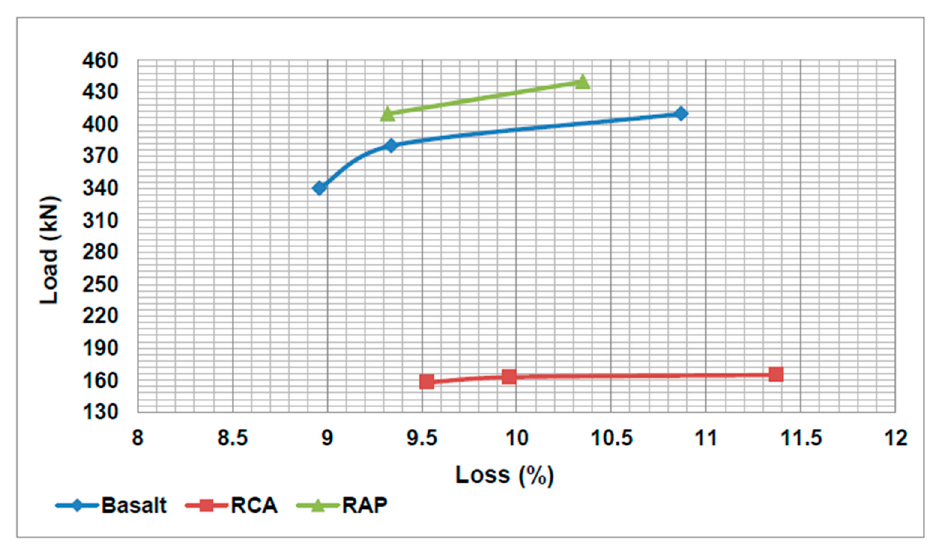
Figure 9. Results of Wet/Dry Strength Test for Coarse Aggregate (Dry Strength).